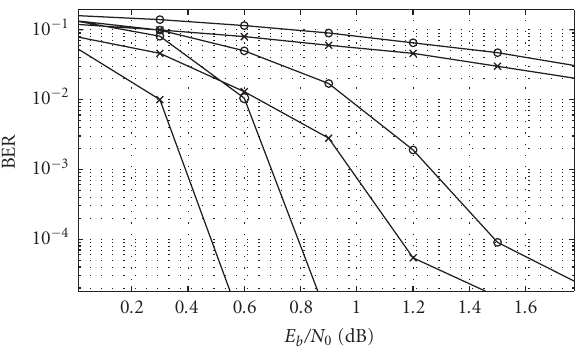
Figure 5: BER after 1st, 3rd, and 7th decoder iterations for UMTS turbo code with ( × -marker) and without ( ◦ -marker) using the prefix